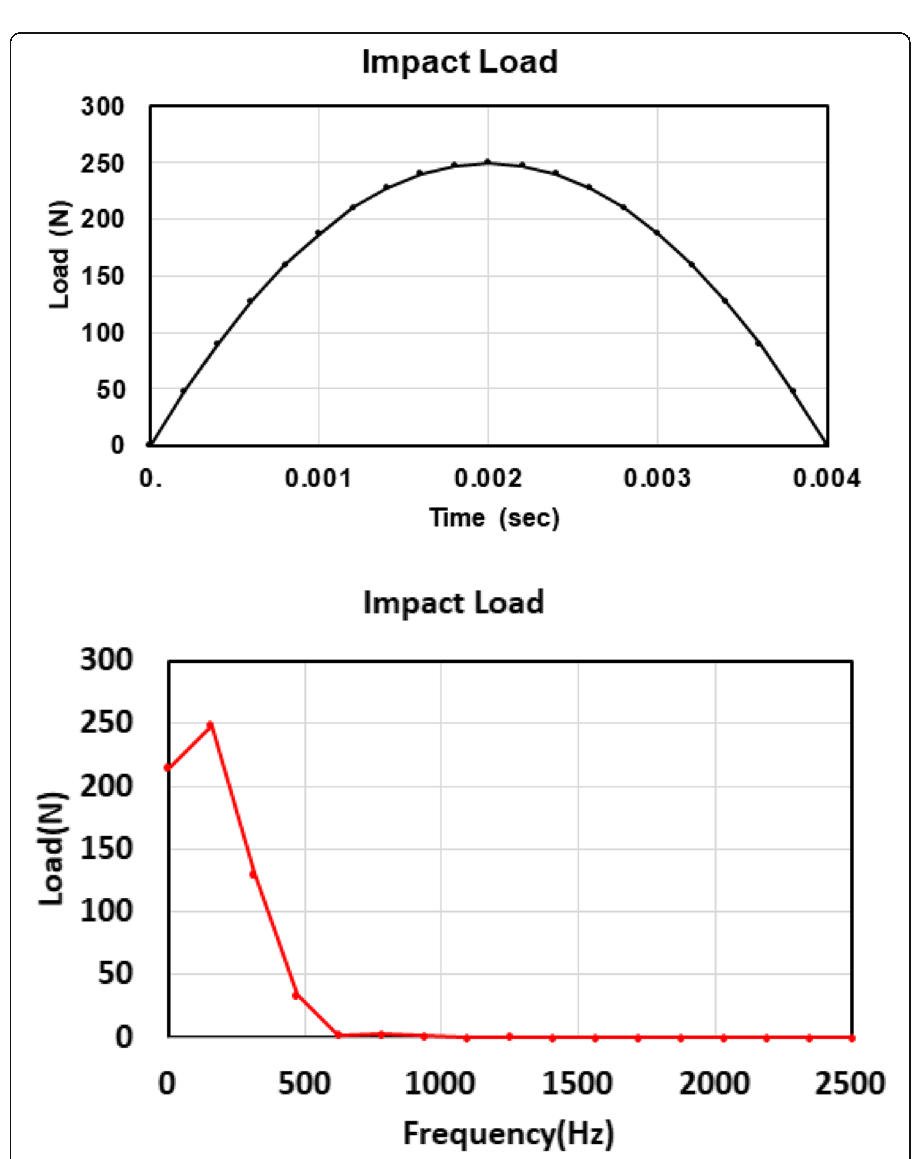
Fig. 12 Semi-sinusoidal and Fourier spectrum load applied to finite element